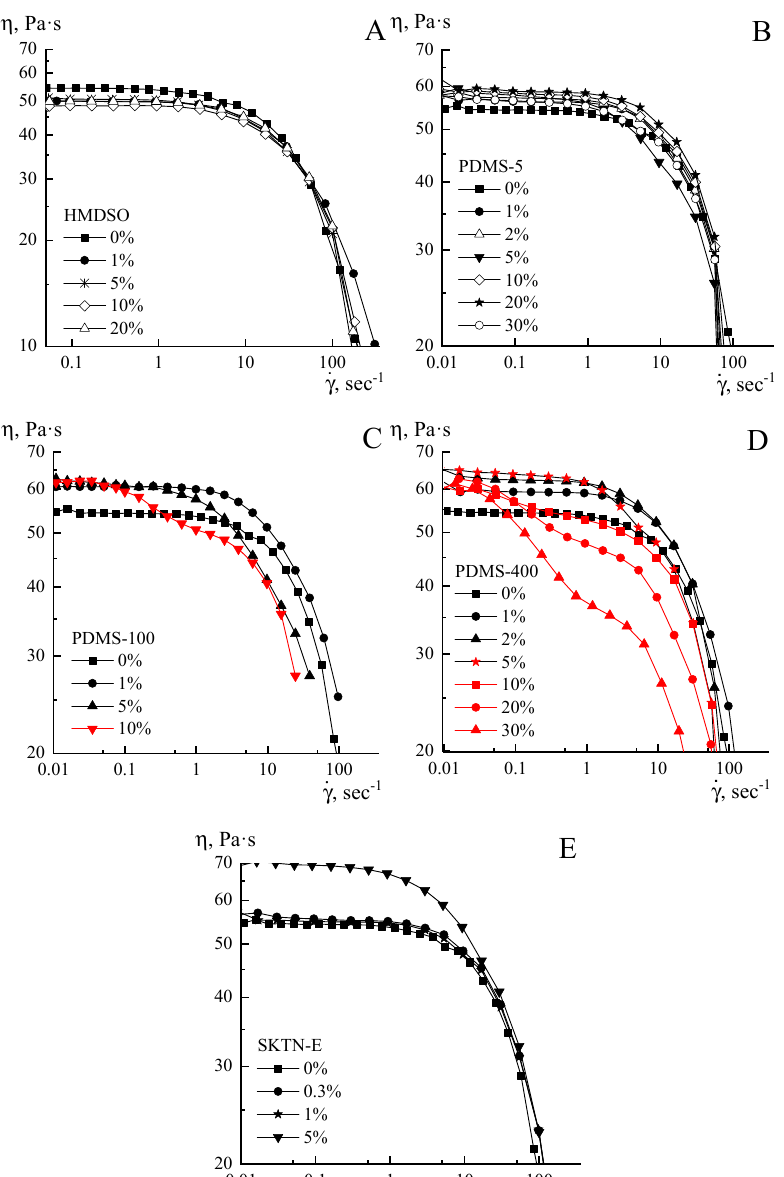
Figure 8. Flow curves of PAN solutions with various amounts of additives (indicated in the graphs) of polysiloxanes of various molecular weights: ( A )—HMDSO, ( B )—PDMS-5, ( C )—PDMS-100, ( D )— PDMS-400, and ( E )—SKTN-E.